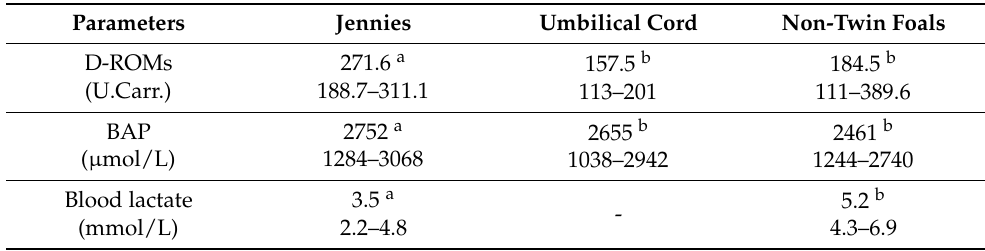
Table 1. d-ROMs and BAP concentrations in dams, umbilical cord, and foals, and blood lactate in foals and their dams expressed as median, minimum, and maximum